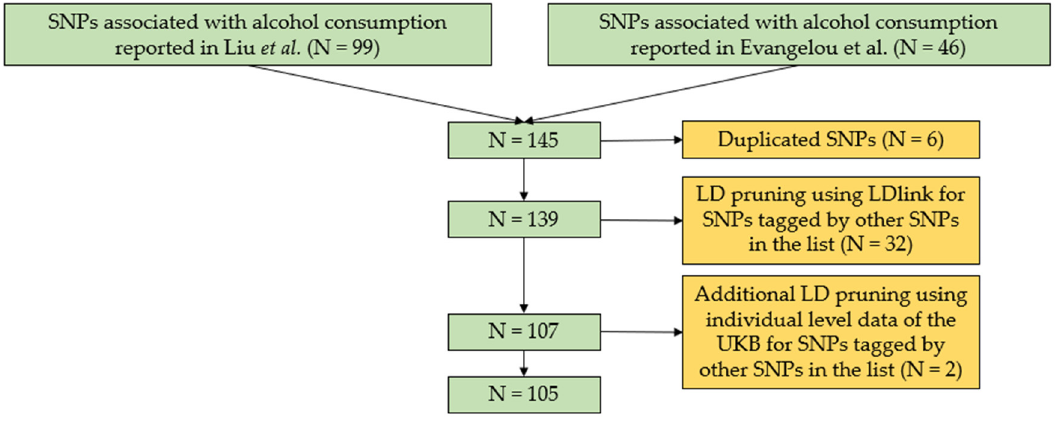
Figure 2. SNPs selection flowchart for the alcohol consumption genetic risk score. Flowchart detailing the SNPs selection process prior to being used in the calculation of the alcohol consumption genetic risk score for UKB participants. We obtained SNPs identified for alcohol consumption from Liu et al. [13] (99 SNPs) and Evangelou et al. [12] (46 SNPs). We first removed duplicates ( n = 6). We then assessed LD (R 2 > 0.1) among the SNPs and identified LD pairs using the LDmatrix function in LDlink [22]. Within each SNP pair, SNPs with a stronger association with alcohol consumption were moved forward (32 SNPs removed). The remaining SNPs underwent extra LD pruning using indi- vidual-level data of the UKB (see methods) (2 SNPs removed). Eventually, 105 SNPs were selected to calculate the alcohol genetic risk score. SNP, single nucleotide polymorphism; LD, linkage dise- quilibrium; UKB, UK Biobank.